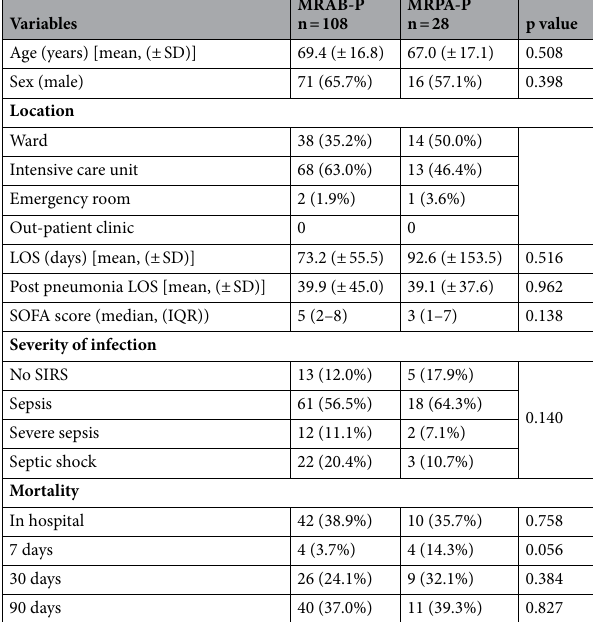
Table 1. Clinical characteristics and outcomes of enrolled patients with pneumonia due to multidrug-resistant Acinetobacter baumannii and Pseudomonas aeruginosa for a 6-month period from ten hospitals in Korea. MRAB-P multidrug resistant A. baumannii pneumonia, MRPA-P multidrug resistant P. aeruginosa pneumonia, LOS length of stay, SD standard deviation, IQR interquartile range, SOFA sequential organ failure score.